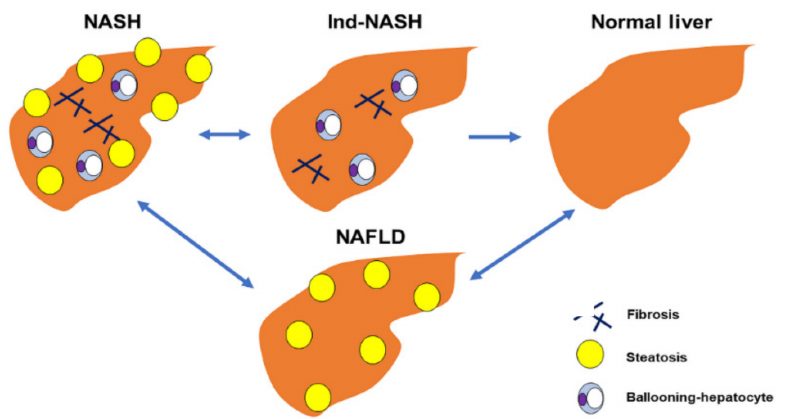
Figure 11. The brand-new concept of Ind-NASH is shown. Ind-NASH lies between NASH and normal liver but does not lie between NAFL and